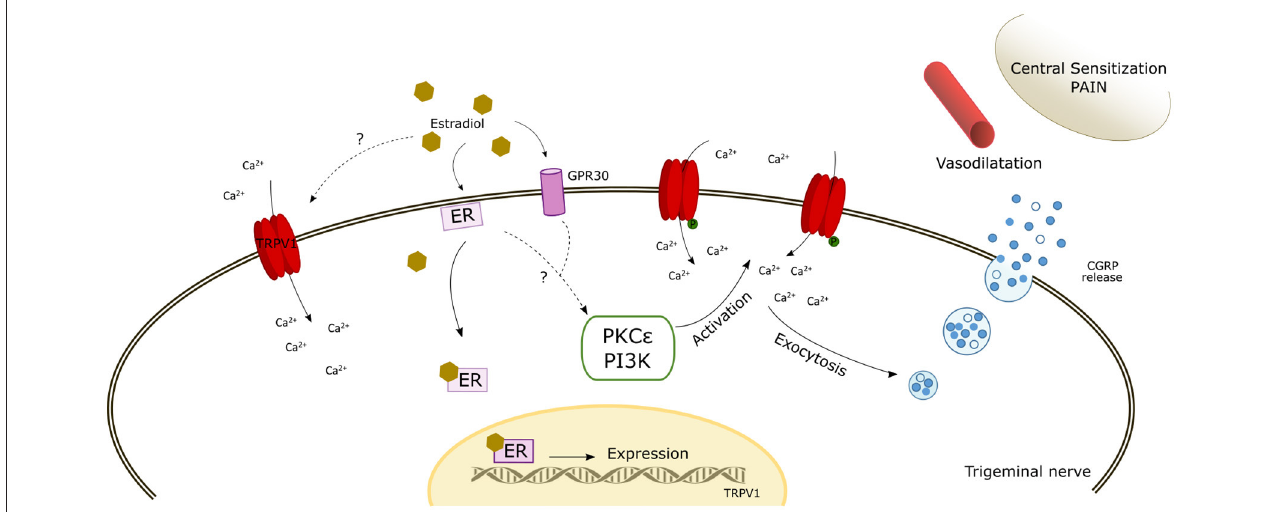
FIGURE 1 | Schematic diagram of the potential mechanisms of action of estrogen modulating TRPV1. The scheme reflects a possible direct activation by estradiol. In addition, the interaction of estradiol with estrogen receptors (ER and GPR30) may induce the expression of TRPV1 and likely activate intracellular signaling pathways that phosphorylate TRPV1 inducing its membrane expression and its activation/sensitization. The increase of intracellular calcium enhances α CGRP release which induces cranial vasodilatation, trigeminal sensitization, and pain. ER, estrogen receptor; PKC ε , Protein Kinase C epsilon; PI3K, Phosphatidylinositol-4,5-bisphosphate